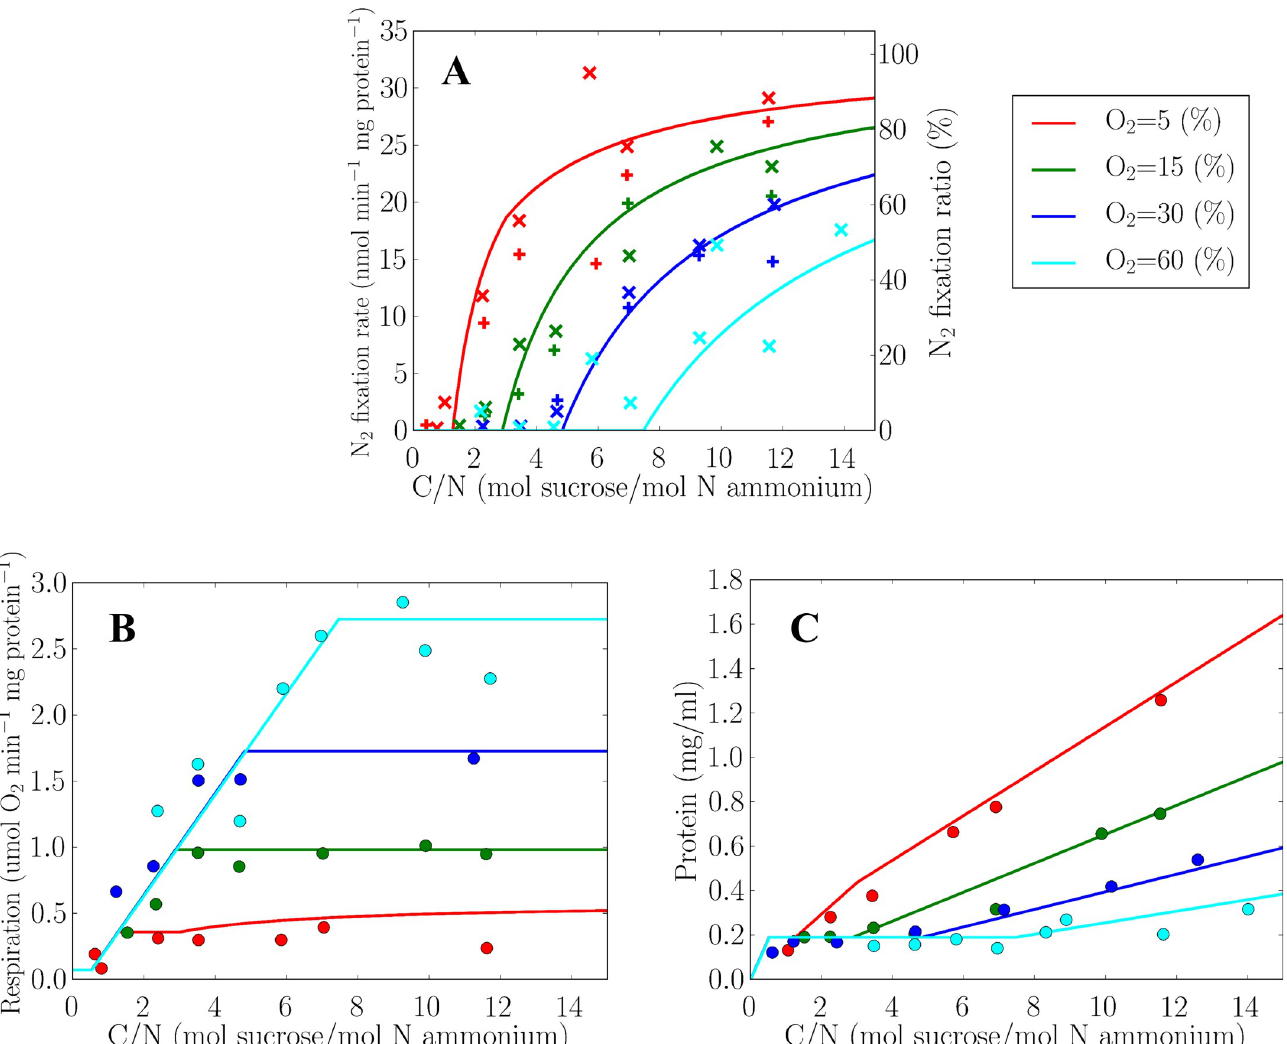
Fig 3. Simulated protein specific rates of (A) nitrogen fixation (B) respiration and (C) concentrations of protein in continuous cultures of Azotobacter vinelandii . The simulations (solid curves) are compared to laboratory data (points) redrawn from [34,41].Different colors represent different O 2 concentration in the culture (see the legend in upper right). Here 100% O 2 equals 225 μ M thus approximately O 2 saturation under normal air composition at 30˚C. At lower to medium C/N in (B) and (C), model results show same values for various O 2 concentrations. In (A), “+” are data based on acetylene reduction, and “ × ” are based on the rate of total nitrogen incorporation. The right y-axis in (A) shows the model predicted ratio of nitrogen fixation relative to total nitrogen incorporated into biomass. In both the simulation and the laboratory data, the dilution rate was constant (0.15 h -1 ), and C/N ratio is based on the constant ammonium resource of 2.5 mol m -3 .